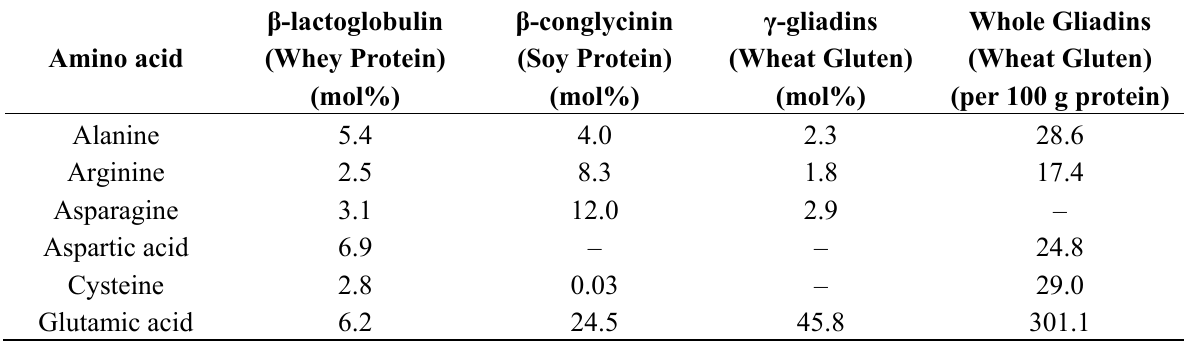
Table 1. Amino acid composition of β-lactoglobulin, β-conglycinin, γ-gliadins and whole gliadins according to